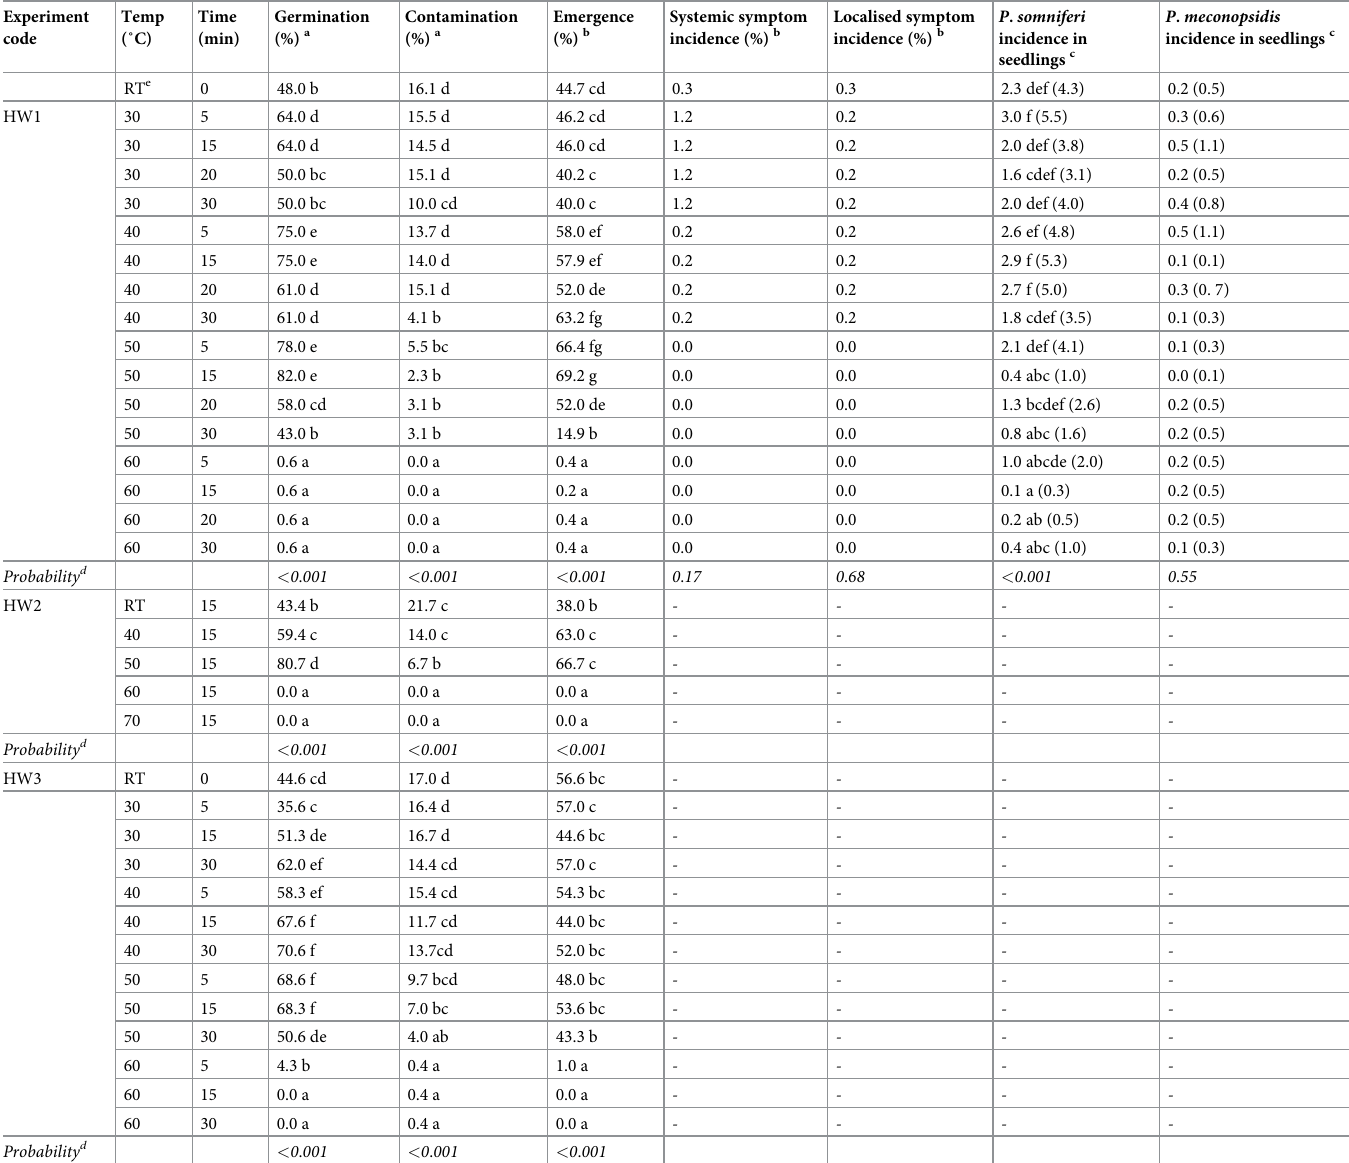
Table 4. The effect of hot water treatment at various temperature and time on the opium poppy seed health and controlling poppy downy mildew. Experiment